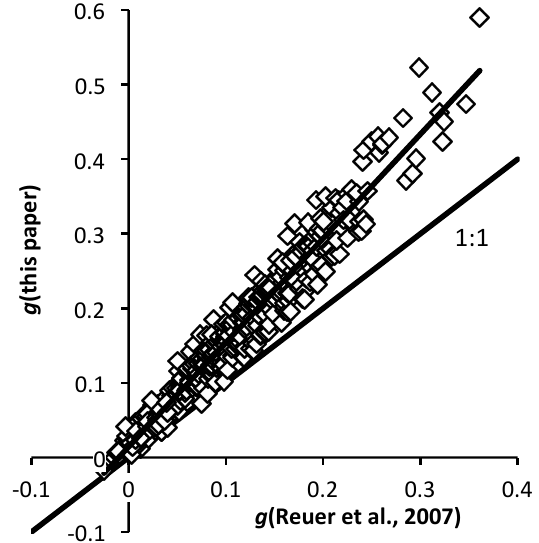
Fig. 4. Comparison between the g values calculated according to columns 5 and 7 in Table 3, based on the biological oxygen su- persaturation 1 (O 2 /Ar) and the 17 δ and 18 δ values given in the Supplement of Reuer et al. (2007). The 18 δ sat values were cal- culated as a function of temperature (Benson et al., 1979). For g (this paper), the temperature parameterisation of 17 1 sat given by Luz and Barkan (2009) was used. For g (Reuer et al., 2007), 17 1 sat = 8ppm was used. Lines on the plot correspond to g (this paper) = g (Reuer et al., 2007) (“1:1”) and a linear regression be- tween both g values, i.e. g (this paper) = (1 . 40 ± 0 . 01) g (Reuer et al., 2007) +0 . 014 ± 0 . 002 ( R 2 = 0 .